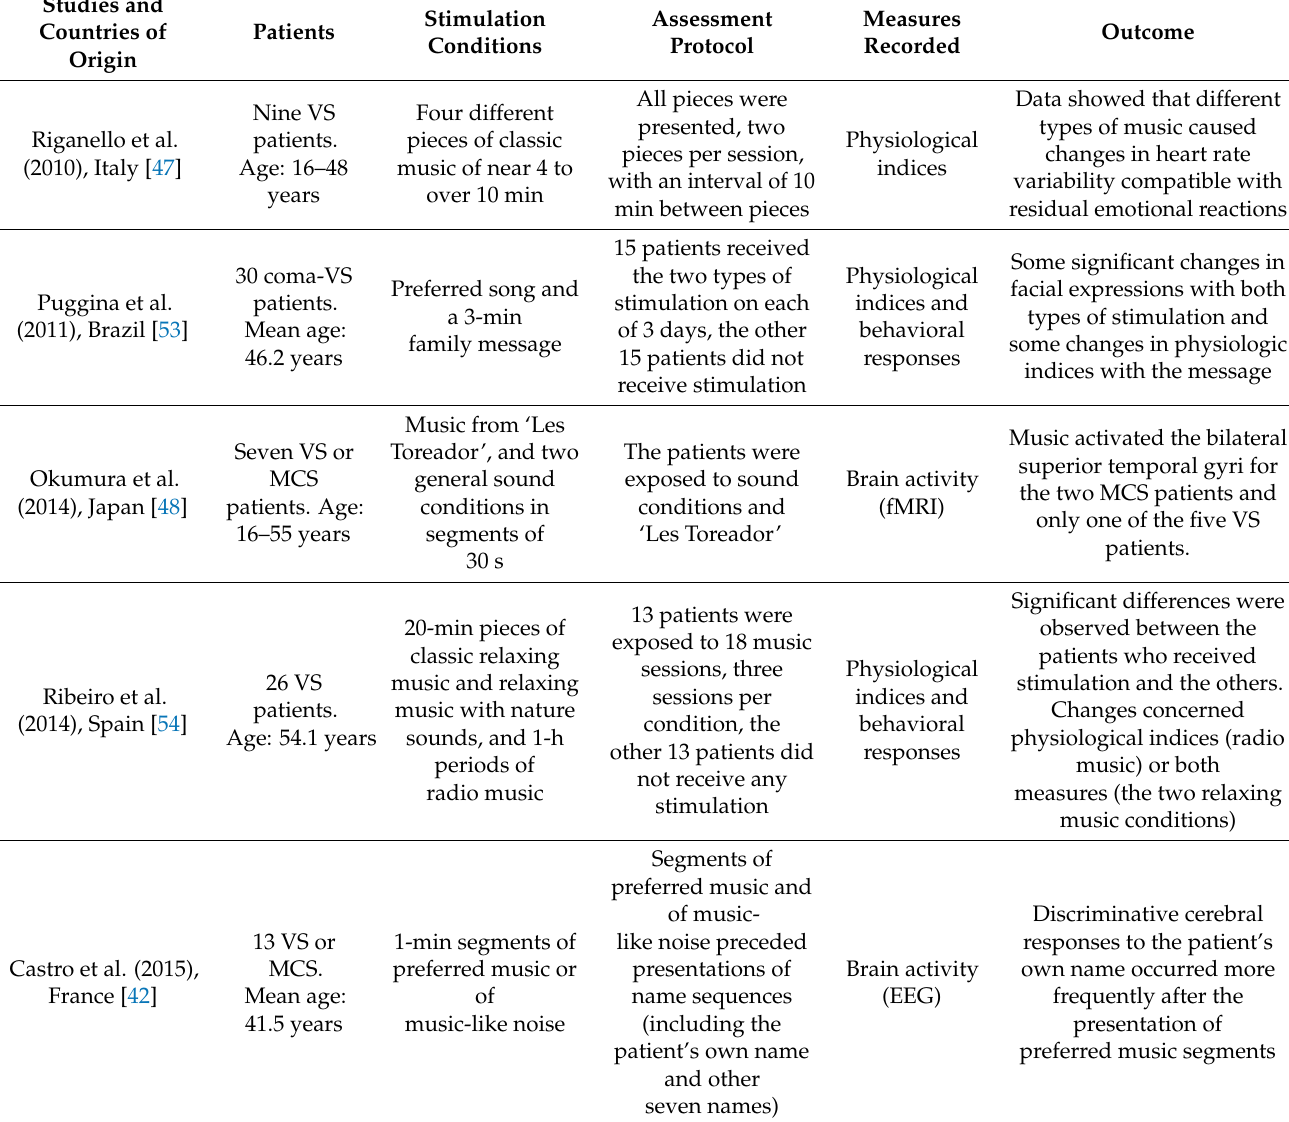
Table 1. Studies Assessing the Impact of Recorded